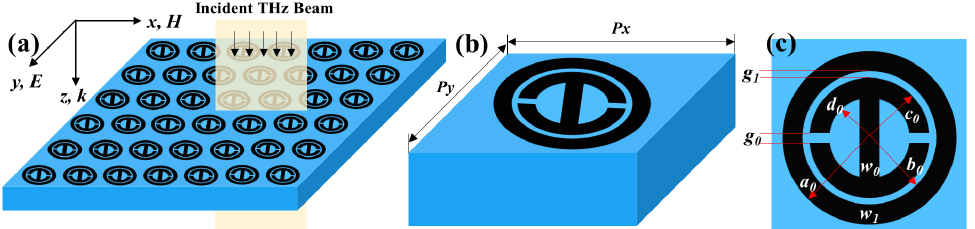
Figure 1. Schematic diagram of the proposed graphene-based metasurface on SiO 2 substrate. ( a ) Pe- riodic structure where the incident THz waves with y-polarization is along the z -axis. ( b ) A unit cell and ( c ) its top view with geometrical parameters. a 0 = 18 µ m, b 0 = 12 µ m, c 0 = 11 µ m, d 0 = 7 µ m, g 0 = 1 µ m, g 1 = 1 µ m, w 0 = 4 µ m, and w 1 = 6 µ m. The periodicity is set to 50 µ m in both x and y